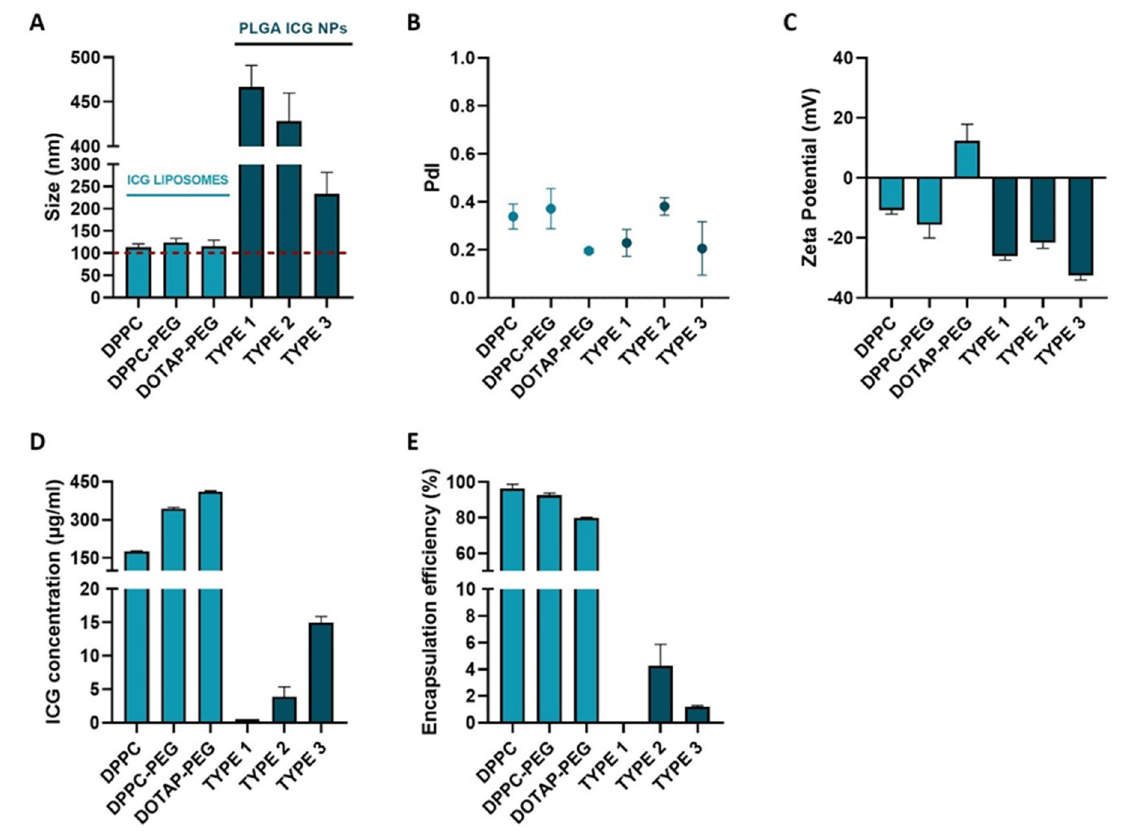
Figure 2. Physicochemical and ICG incorporating characterization of ICG liposomes (DPPC, DPPC- PEG and DOTAP-PEG) and PLGA ICG NPs (types 1–3). ( A ) Hydrodynamic diameter. ( B ) PdI. ( C ) Zeta Potential. ( D ) Total ICG concentration. ( E ) Encapsulation efficiency of ICG.